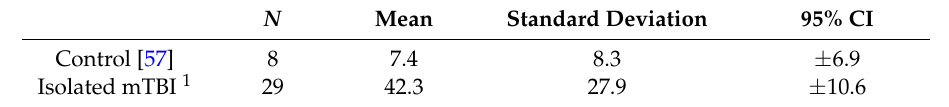
Table 2. Platelet ADP inhibition in isolated mTBI patients with CT abnormalities compared to